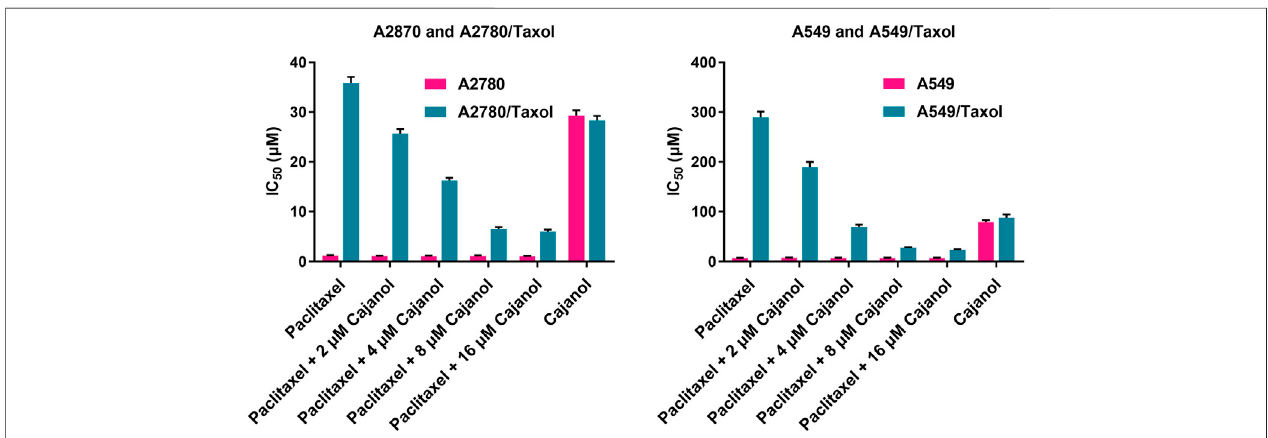
FIGURE2| Effectofcajanol onintracellular Rhodamine-123 accumulation inA2780and A2780/Taxolcells.Rhodamine-123 fl uorescence intensitywasmeasured using a fl ow cytometer and expressed as the mean ± SD. * p < 0.05, ** p < 0.01 vs. A2780.